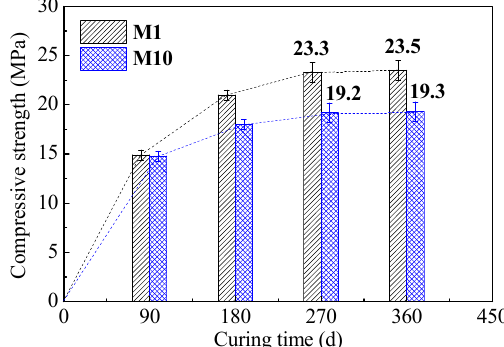
Figure 3. Compressive strengths development of (SR–) FFA–GEO mortars M1 and M10 at up to 360 days.